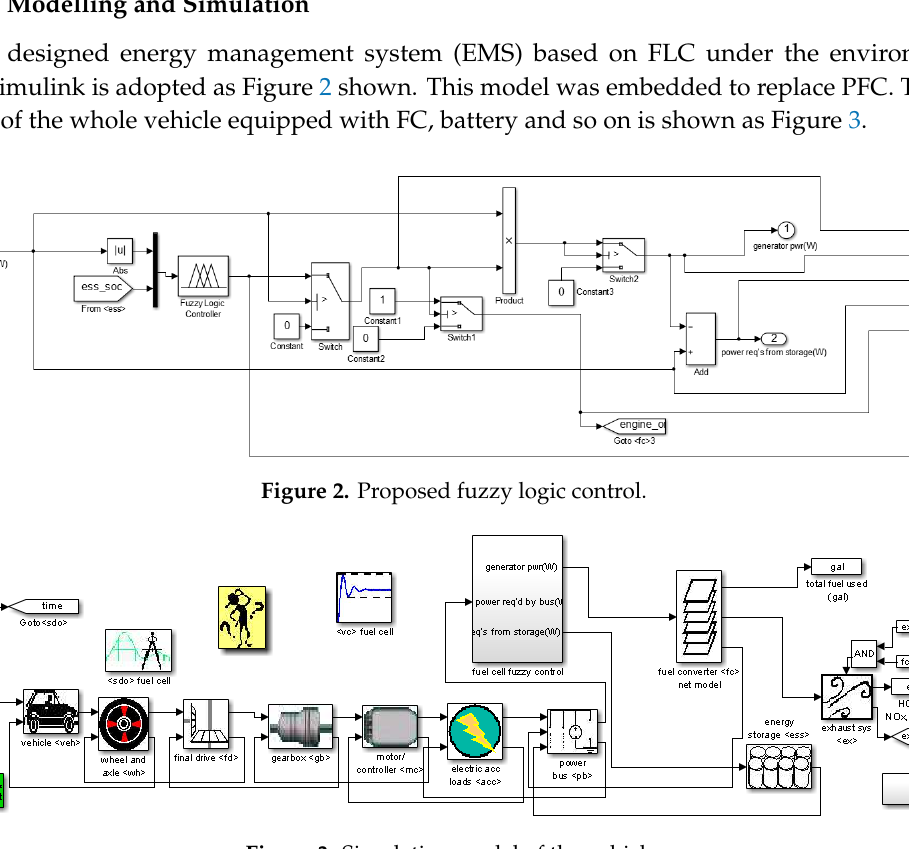
Table 4. Parameters of driving cycle.